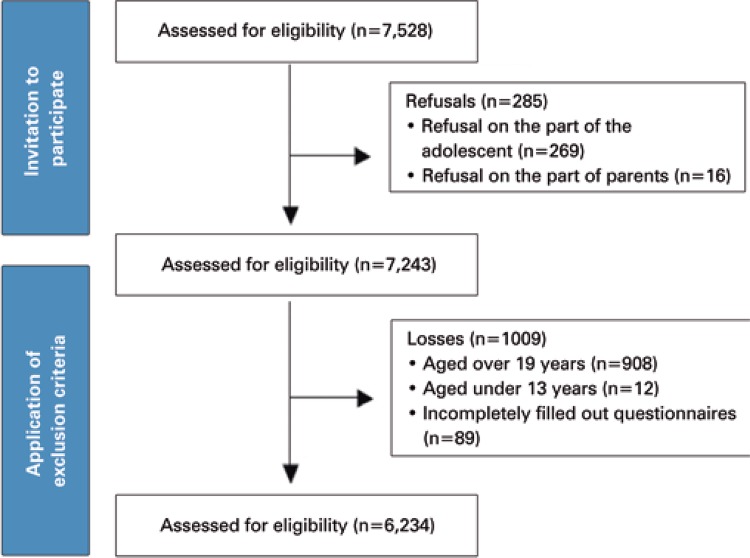
Flowchart representing the inclusion of students of the State of Pernambuco in the study